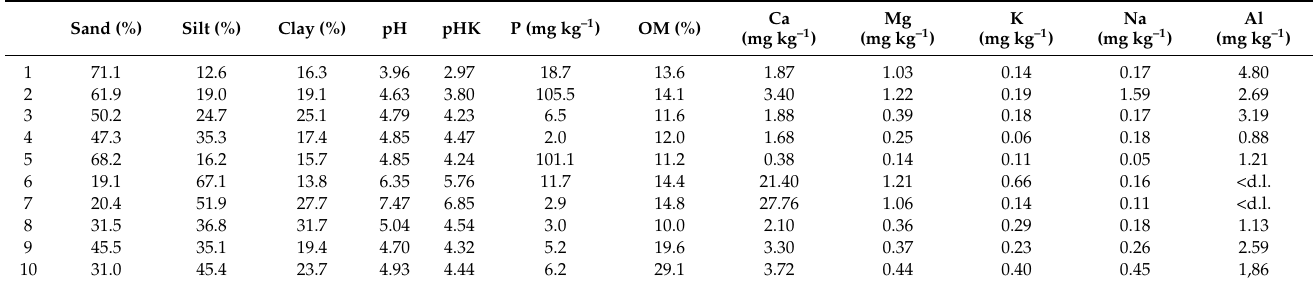
Table 1. Summary of the soil properties used in this